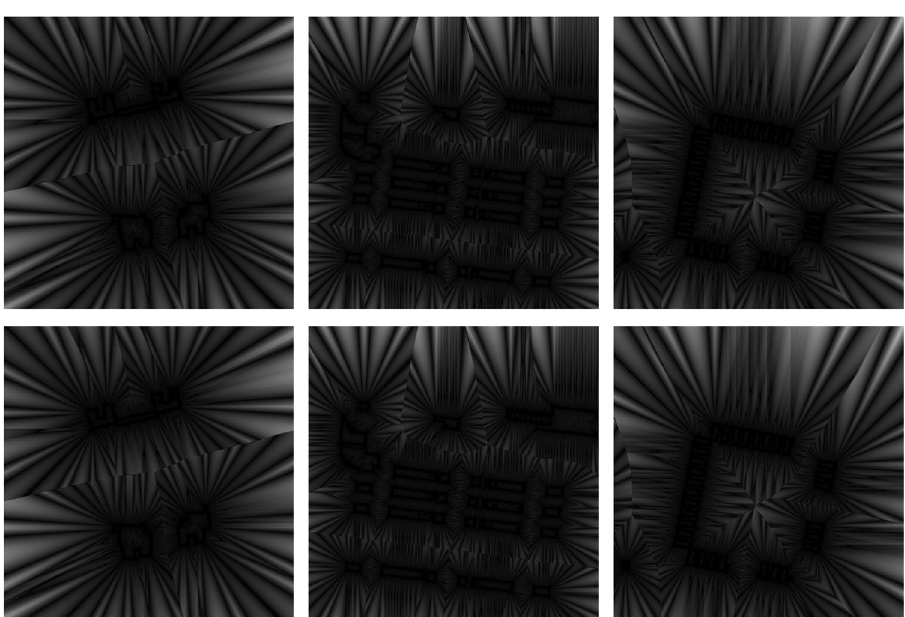
Figure 6. Error maps generated by different metrics: first row, Butt and Maragos; and, second row, our